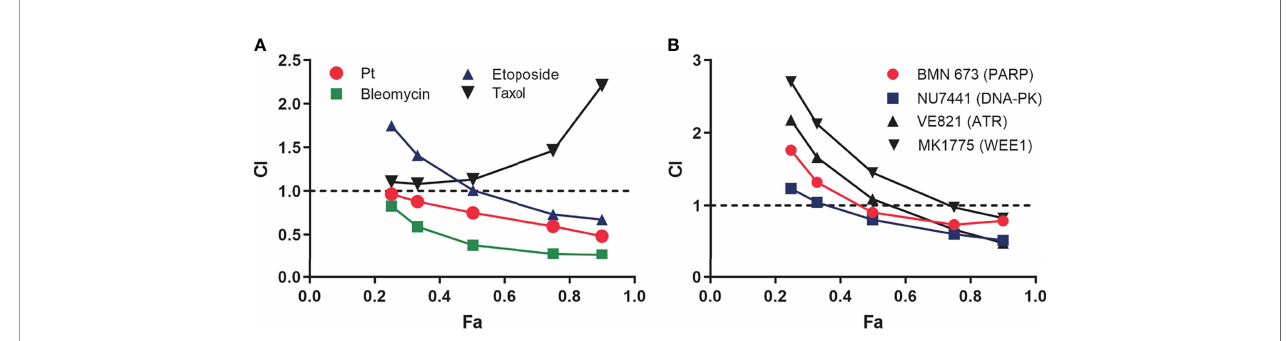
FIGURE 6 | Analysis of replication protein A inhibitor (RPAi) 329 combination treatment. (A) Chou-Talalay analysis of combination with chemotherapeutics. The combination index (CI) is plotted as a function of the fraction of cell affected (Fa) for each treatment combination of the 329. (B) Chou-Talalay analysis of combination with DDR-targeted agents as described in panel (A) .